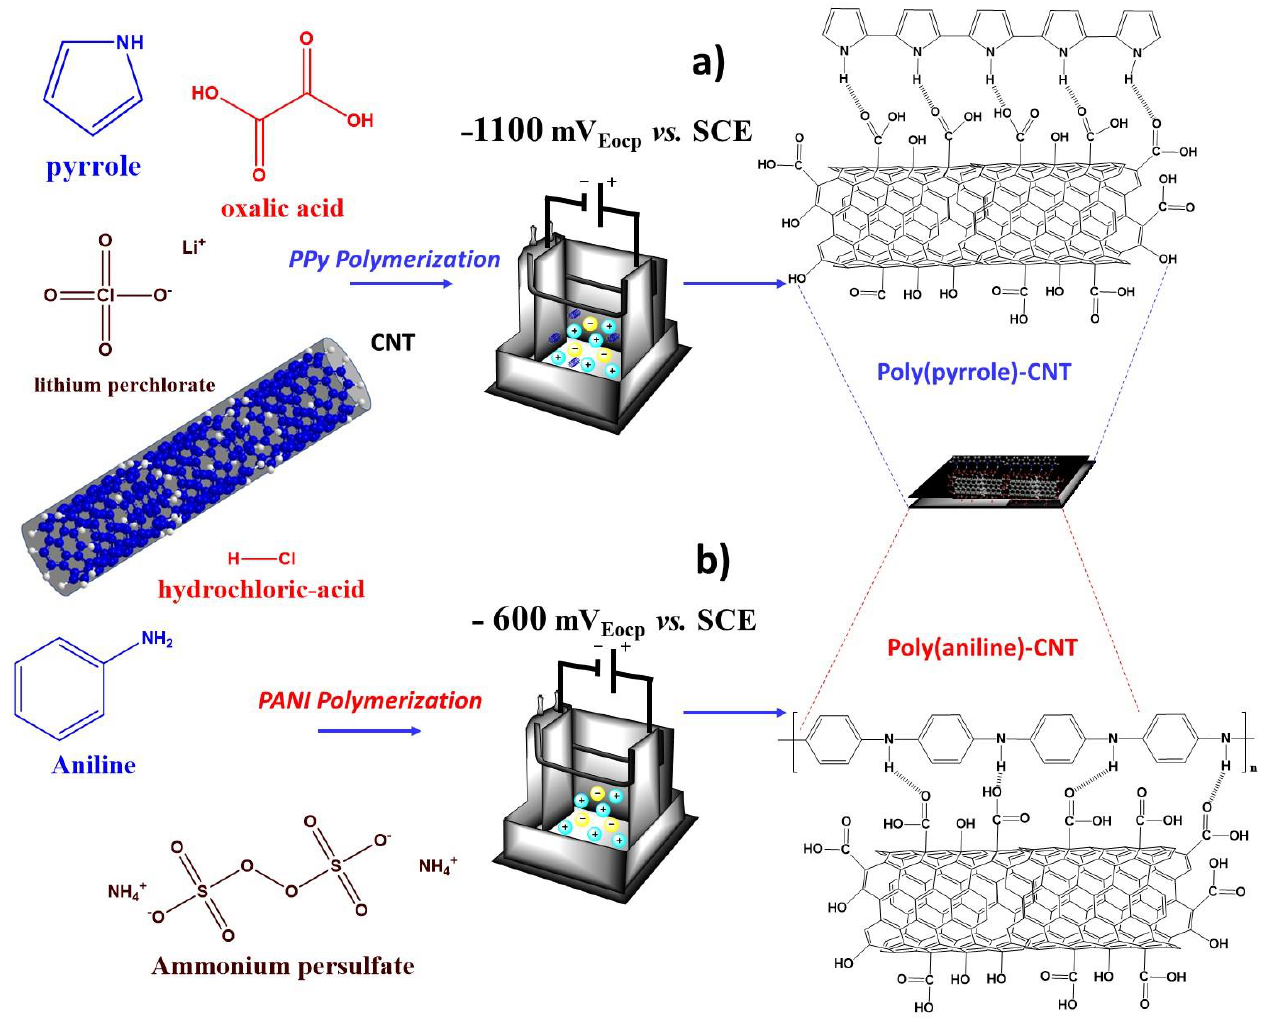
Figure 7. Physical interactions proposed for electropolymerized composites between ( a ) PPy, ( b ) PANI, and MWCNTs.